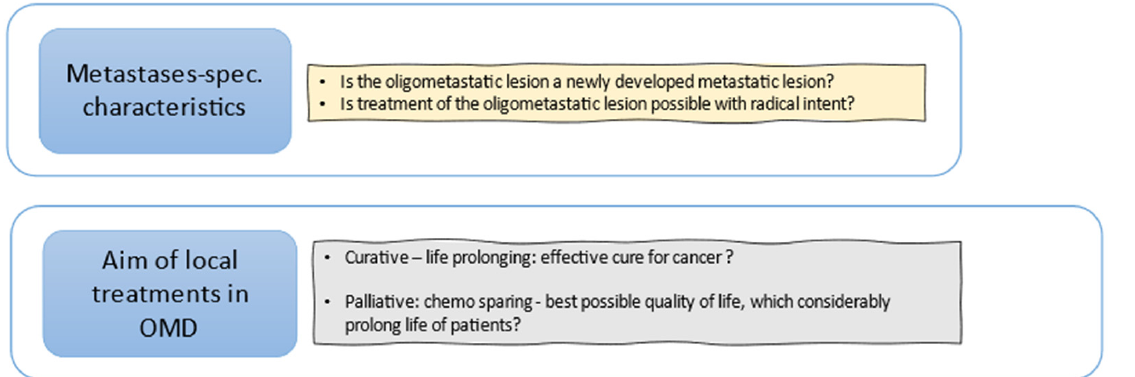
Figure 1. Useful questions to further define OMD, based, with modifications, on (Guckenberger et al., 2020) [18].